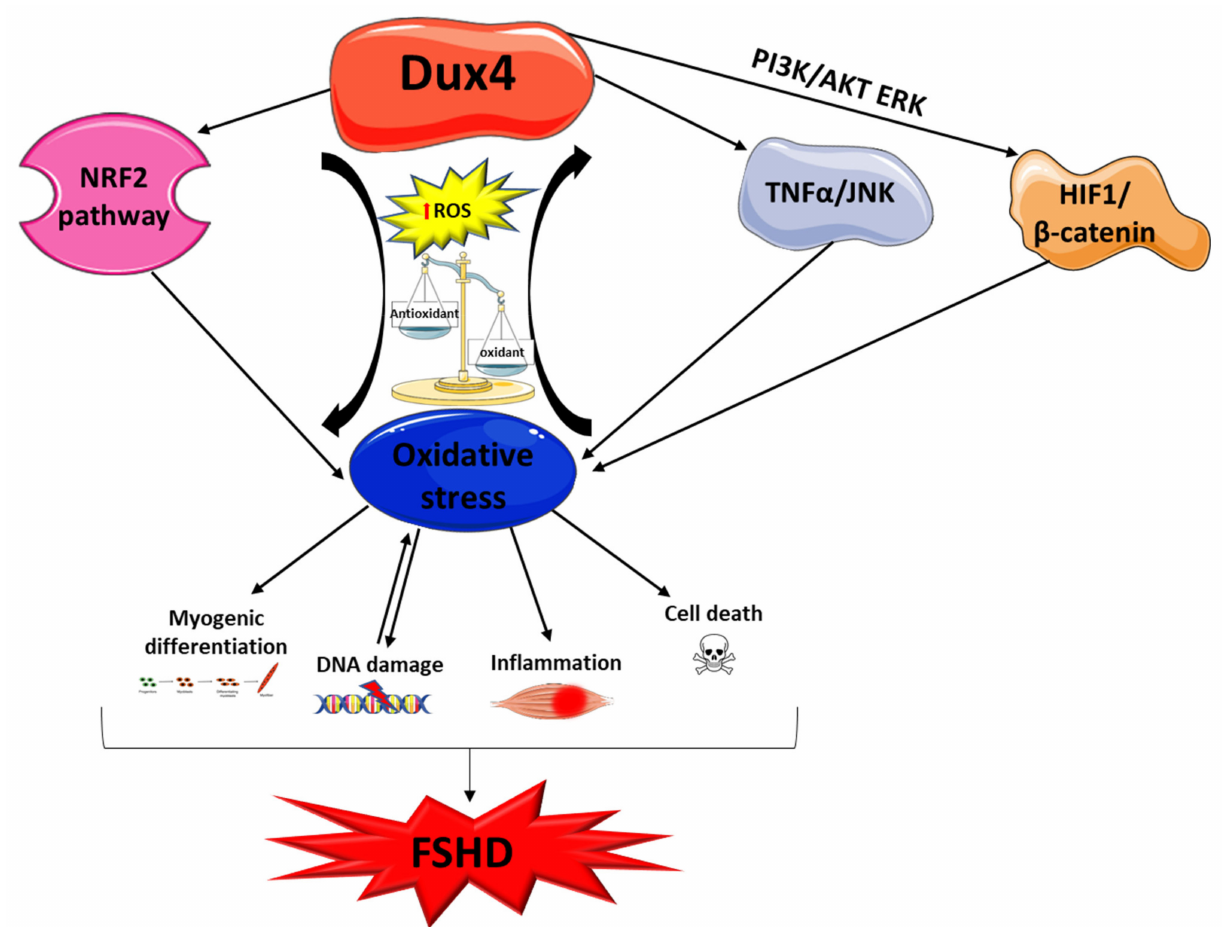
Figure 2. Interplay between DUX4 and oxidative stress in FSHD. This schematic highlights the role of DUX4 in oxidative stress induction during FSHD development and progression. Abbreviations: DUX4: double homeobox 4; Nrf2: nuclear factor erythroid 2-related factor 2; ROS: reactive oxygen species; PI3K: phosphatidylinositol 3-kinase; ATK: protein kinase B; ERK: mitogen-activated protein kinase, TNF- α : tumor necrosis factor alpha; JNK: c-Jun N-terminal kinase; HIF-1: hypoxia-inducible factor